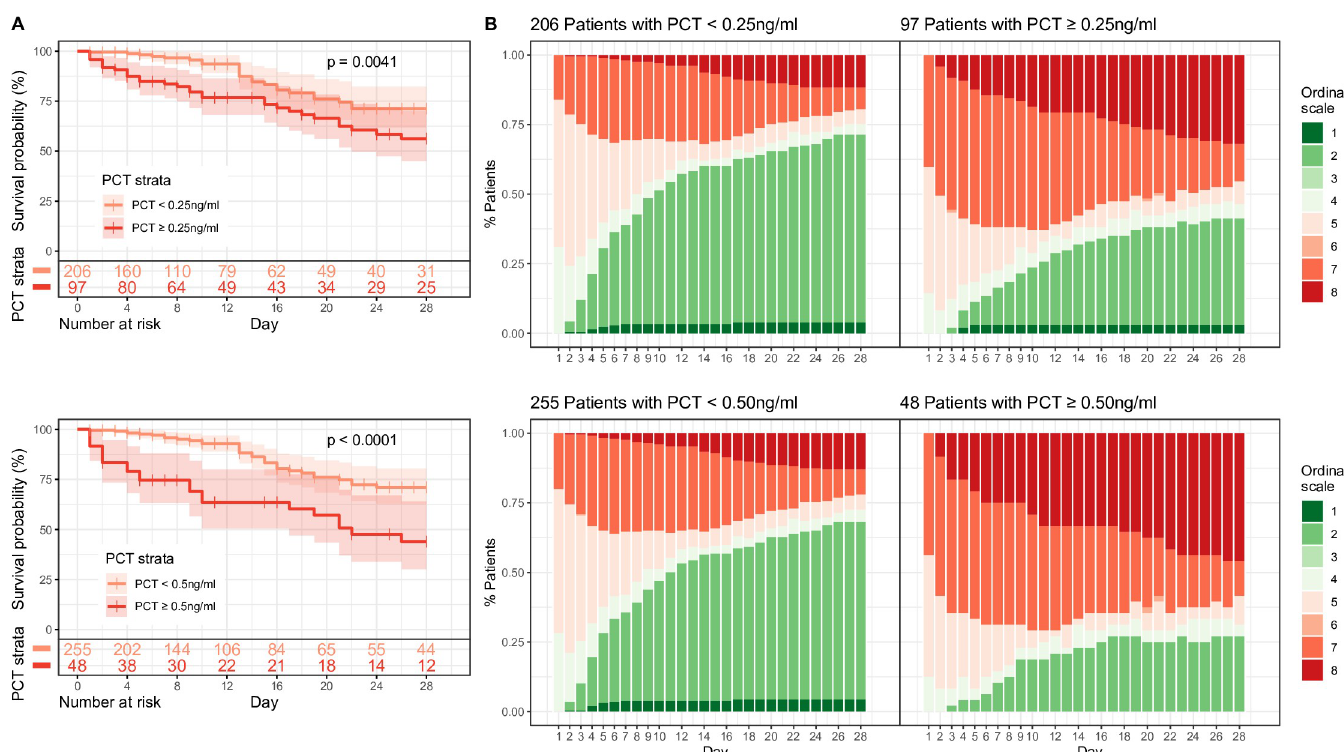
Fig 4. Kaplan-Meier survival plots are separated by PCT strata over time (Panel A). Clinical score (ordinal scale) is plotted over time and stratified by baseline PCT levels (Panel B).